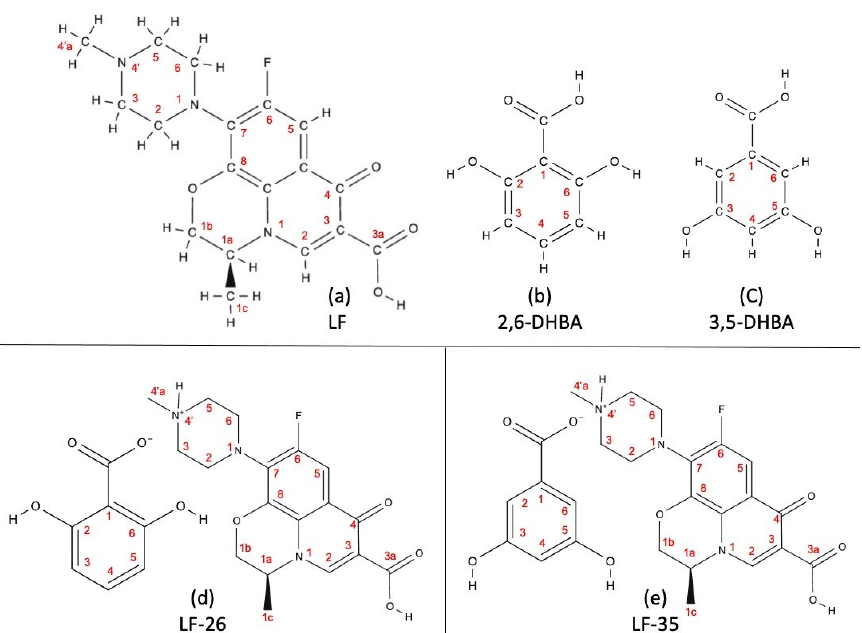
Figure 7. The numbering system for the molecule structures of ( a ) 2,6-DHBA; ( b ) LF; ( c ) 3,5-DHBA; ( d ) LF-26; ( e ) LF-35. Note: LF = levofloxacin; DHBA = dihydroxybenzoic acid; LF-26 = levofloxacin